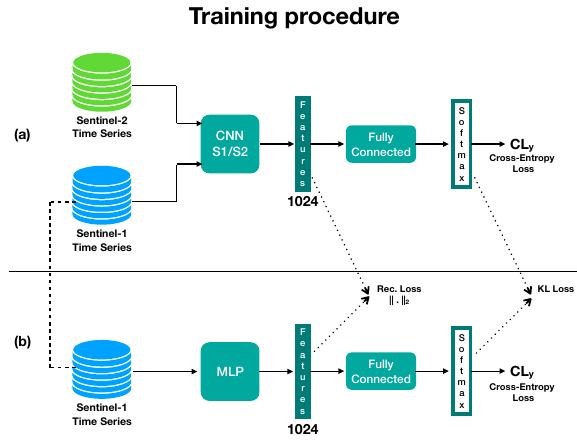
Table 2. CNN architecture of the multi-source (teacher) module.